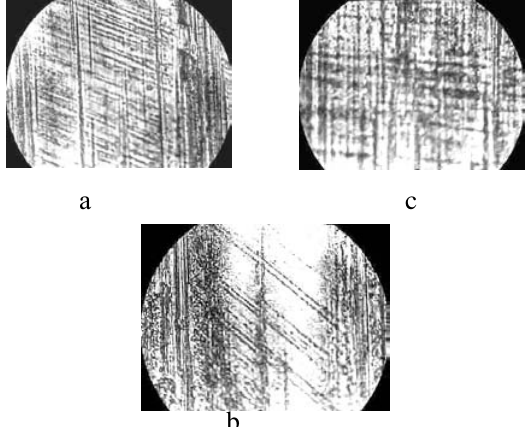
Fig 3. Fractographies of MCL surface at “instantaneous” alteration of applied loading (×300): а ; c – σ =1000 М P а , stages 1, 3; в – σ = 600 М P а , stage